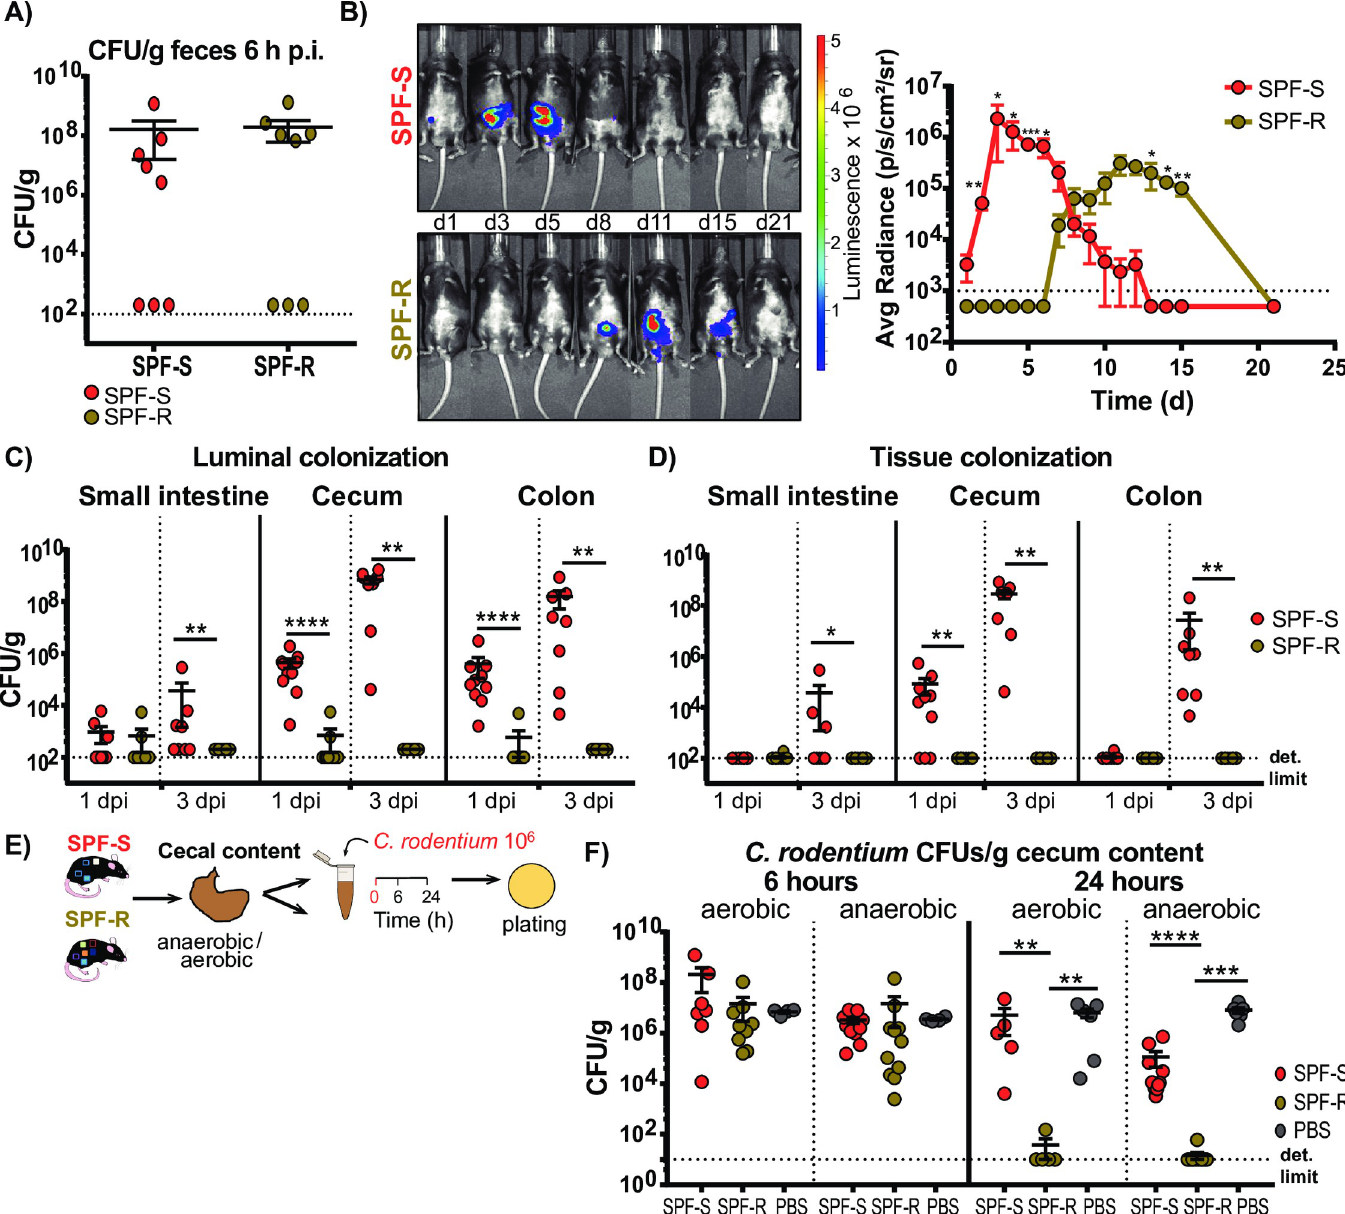
Fig 3. Delayed colonization in SPF-R mice is visible in all intestinal organs and tissues but most prominent in the cecum. (A) SPF-S and SPF-R mice were infected orally with 10 8 CFU C . rodentium and fecal colonization was determined after 6 hours post infection (p.i.). (B) SPF-S and SPF-R mice were infected orally with 10 8 CFU C . rodentium and infection was imaged in vivo using an IVIS imaging system. Average radiance (p/s/cm 3 /sr) was determined at day 1, 3, 5, 8, 11, 15 and 21 p.i. (C-D) SPF-S and SPF-R mice were infected orally with 10 8 CFU C . rodentium and sacrificed after 1 day or 3 days p.i. CFU/g organ content and tissue was determined. Dashed lines indicate the limit of detection. Results represent two independent experiment with n = 5–7 mice/group as mean ± SEM. P values indicated represent a nonparametric Kruskal-Wallis test � p < 0.05, �� p < 0.01, ��� p < 0.001, ���� p < 0.0001. (E) Isolated cecal content of SPF-S and SPF-R mice was diluted 1:1 in PBS, inoculated with 10 6 CFU C . rodentium and cultivated under aerobic and anaerobic conditions for 24 h before plating on selective agar plates. (E-F) Recovery of C . rodentium in isolated cecal content after 6 and 24 h of aerobic and anaerobic cultivation. Dashed lines indicate the limit of detection. Results represent one or two independent experiments with n = 5–7 mice/group as mean ± SEM. P values indicated represent a Mann-Whitney U test comparison between groups with �� p < 0.01, ��� p < 0.001, ���� p < 0.0001.